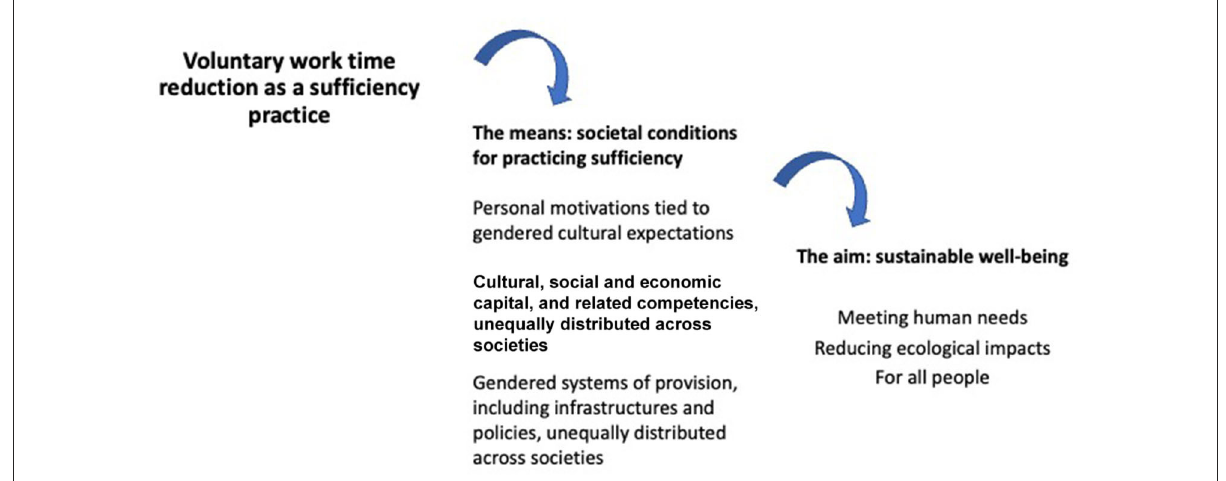
FIGURE1 Conceptualization of how voluntary work time reduction might lead to sustainable